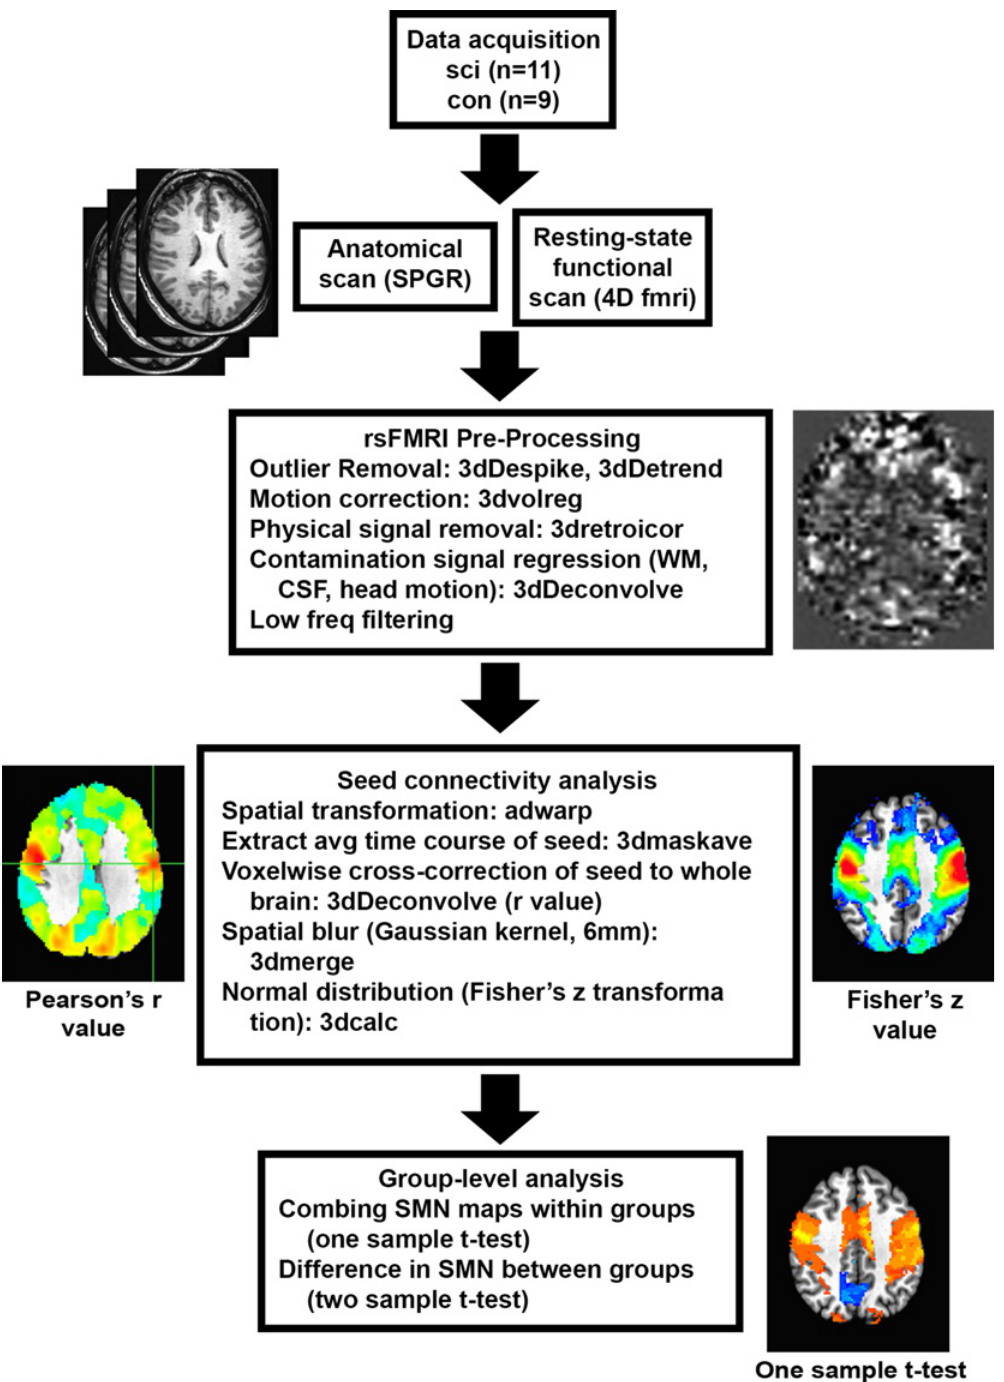
Fig 1. Overview of Data Process. Top to bottom: Data acquisition, preprocessing to obtain individual sensorimotor network maps, and statistical analysis for group-level comparisons. SCI, spinal cord injury; con, control; SPGR, spoiled gradient-recalled echo sequence; fmri, functional magnetic resonance imaging; rsFMRI, resting state functional magnetic resonance imaging; WM, white matter; CSF, cerebrospinal fluid; SMN, sensory motor network.